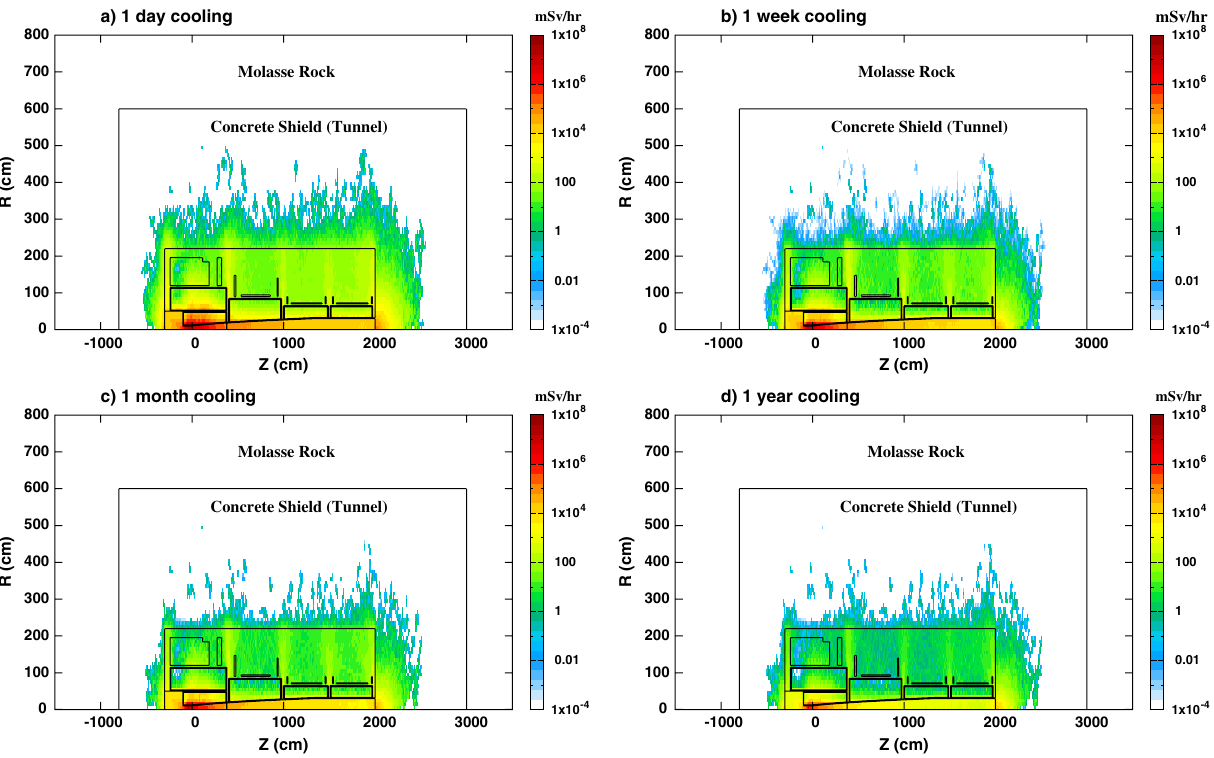
FIG. 8. Ambient dose equivalent rates for the target station, concrete shielding tunnel, and surrounding underground